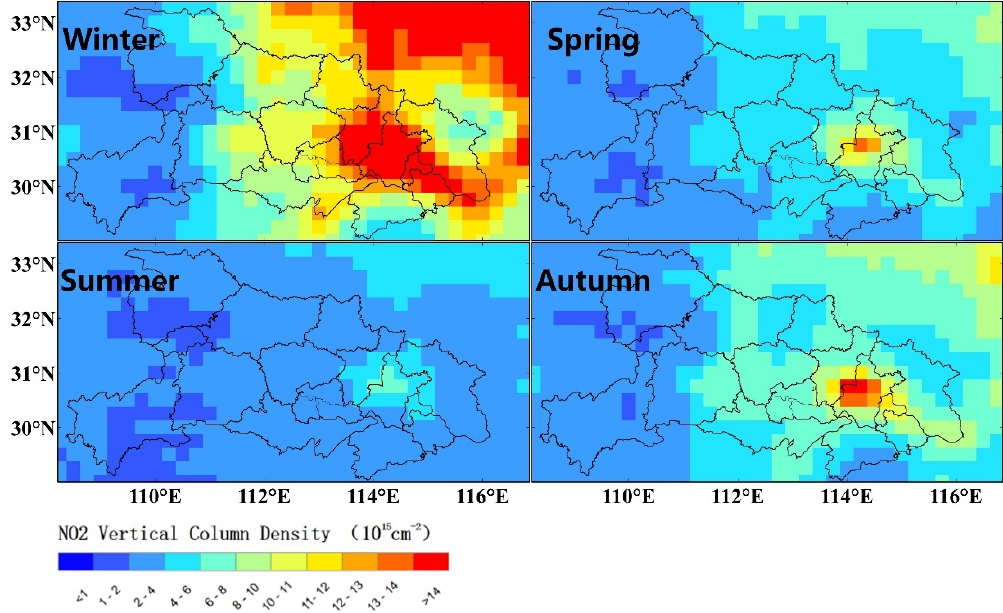
Figure 7. Seasonal OMI tropospheric NO 2 and VCD during 2013–2017.